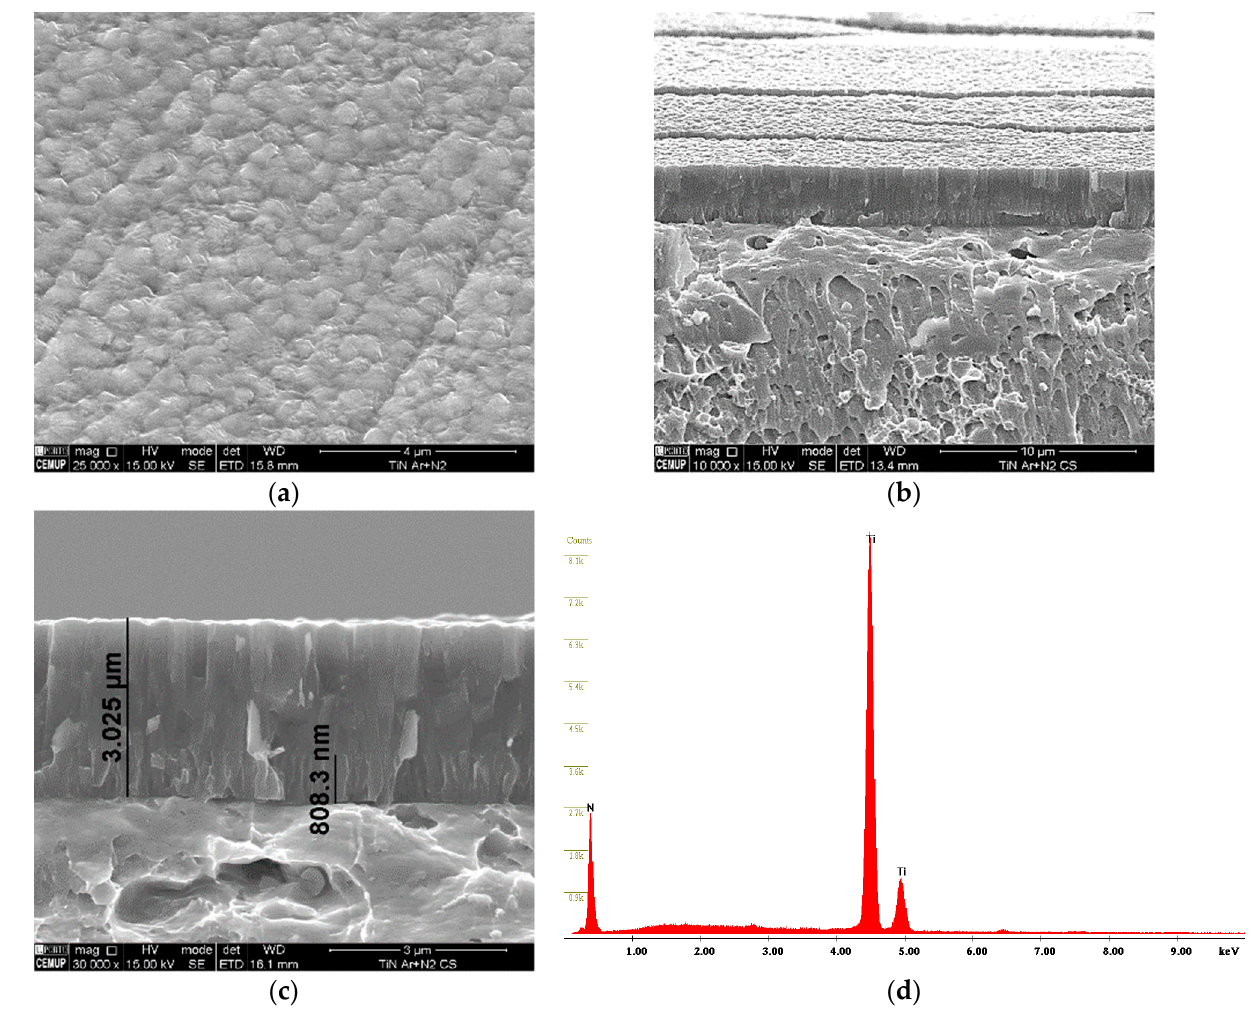
Figure 3. Morphological characterization of the TiN coating: ( a ) coating surface, ( b ) coating surface and thin film cross-section, ( c ) thin film cross-section, ( d ) TiN EDS spectra.